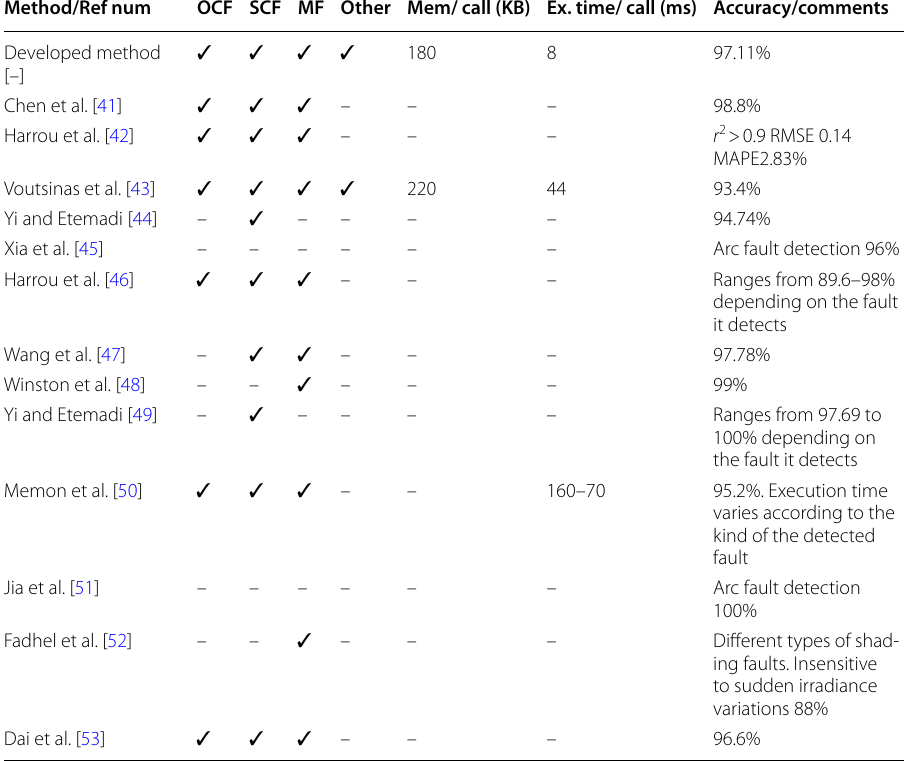
Table 5 Comparison of the methods Method/Ref